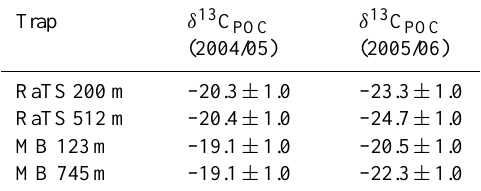
Table 1. Sediment trap seasonal flux-weighted average δ 13 C POC presented in ‰ versus VPDB; maximum error quoted as the 1.0‰ uncertainty associated with formaldehyde preservation (Mincks et al., 2008), as this vastly exceeds analytical